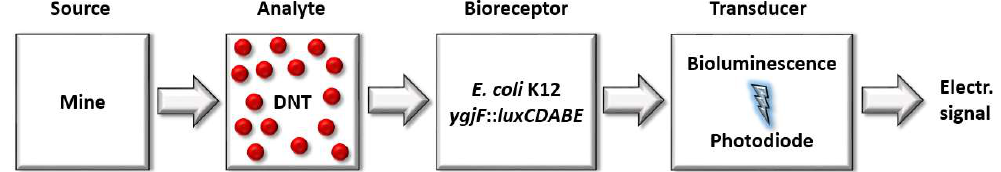
Figure 1. Scheme of the proposed biosensor for the detection of 2,4-DNT evaporating from buried landmines. The production of luciferase in recombinant E. coli cells is triggered by 2,4-DNT, which leads to a bioluminescence emission peak at 490 nm. A silicone photodiode acts as a transducer and converts the bioluminescence into a quantifiable, electrical signal.